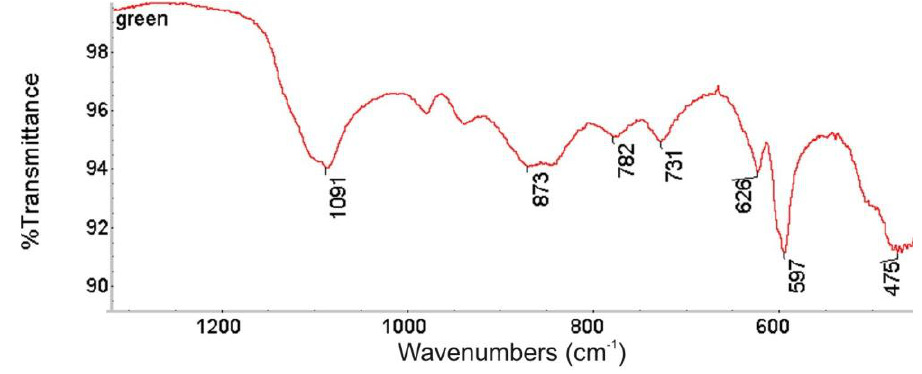
Figure 11. FTIR spectrum of the green layer shown in Figure